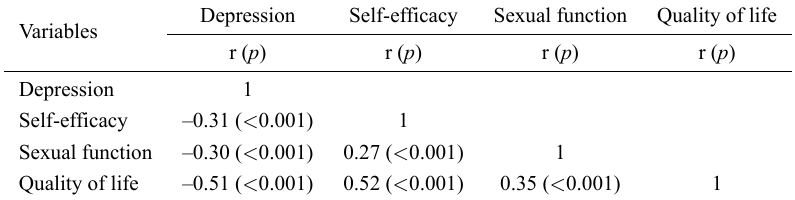
Table 3. Correlation of depression, self-efficacy, sexual function, and quality of life (N = 216).